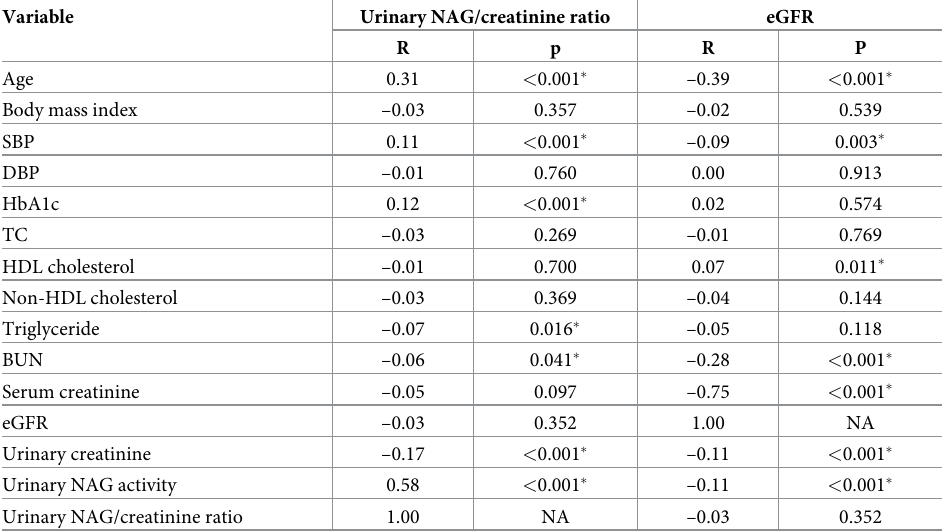
Table 3. Correlations between baseline urinary N -acetyl- β - D -glucosaminidase activity–urinary creatinine concen- tration ratio (urinary NAG/creatinine ratio), estimated glomerular filtration rate (eGFR), and other variables.